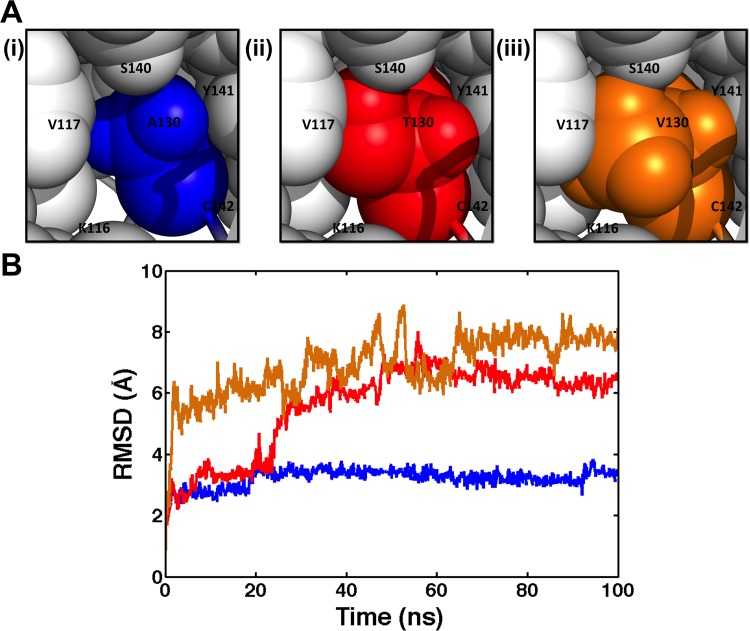
Effects of mutating of residue A130.(A) Homology modeling of Bbox1 structures highlighting the position and packing of side chain of A130 (i) compared to those of the T130 (ii) and V130 (iii). (B) Backbone RMSDs for WT (blue), A130T (red), and A130V (orange) during the MD simulations.